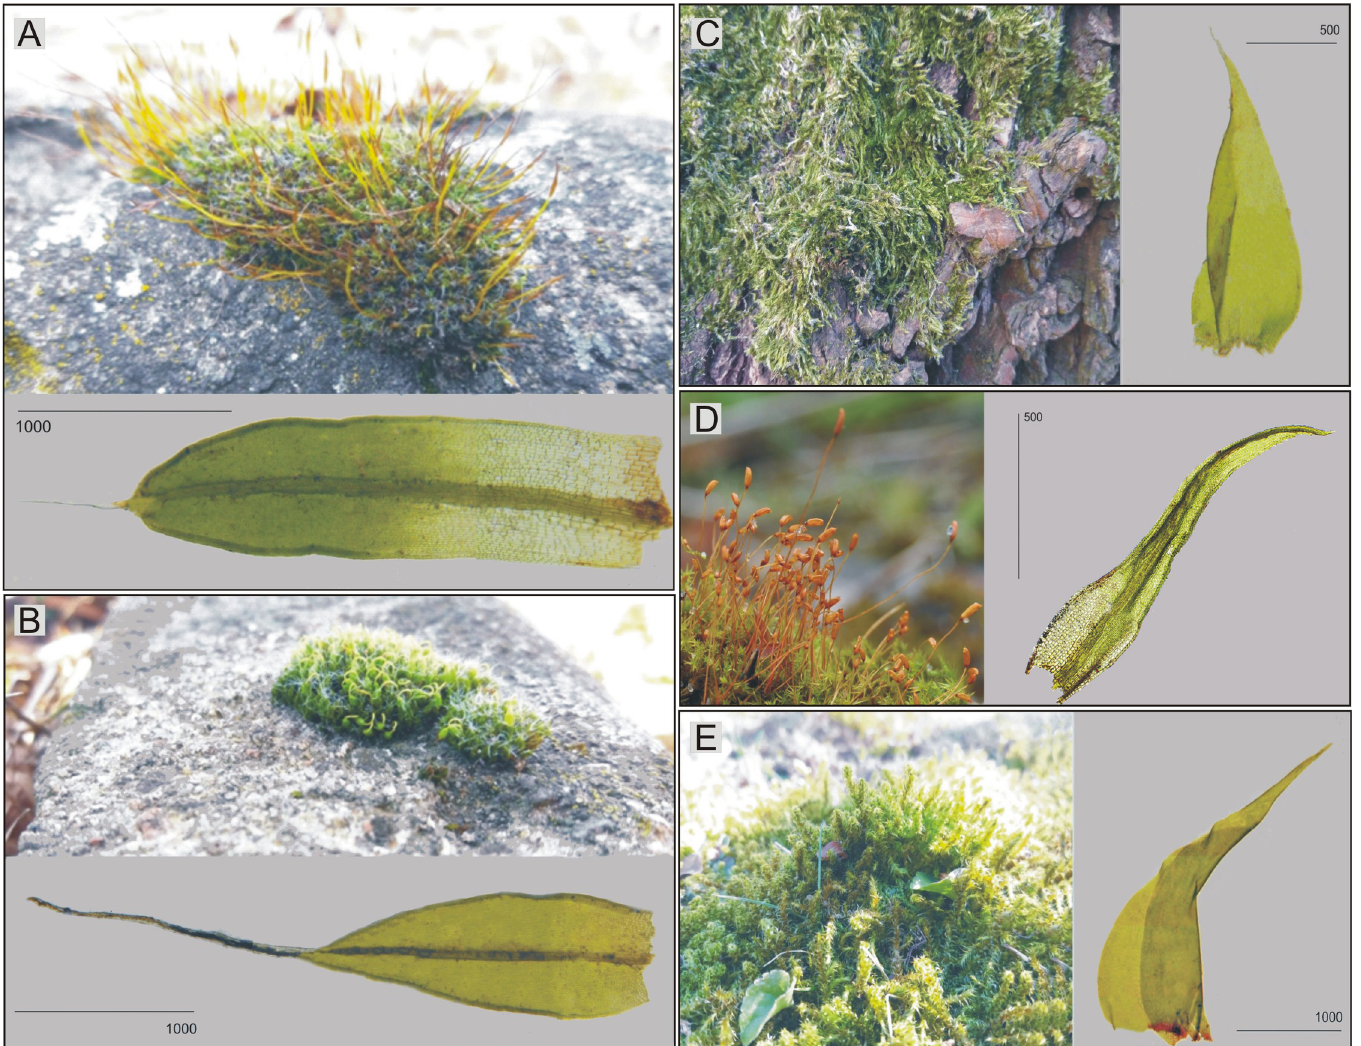
Fig 1. Studied moss species, their stem leaf and habitat. A– T . muralis , B– D . pulvinatus , C– H . cupressiforme , D– C . purpureus , E– R . squarrosus ; scale in μ m (foto. G. J. Wolski, Scientific and Didactic Garden, Faculty of Biology and Environmental Protection, University of Lodz, 08.03.2019).